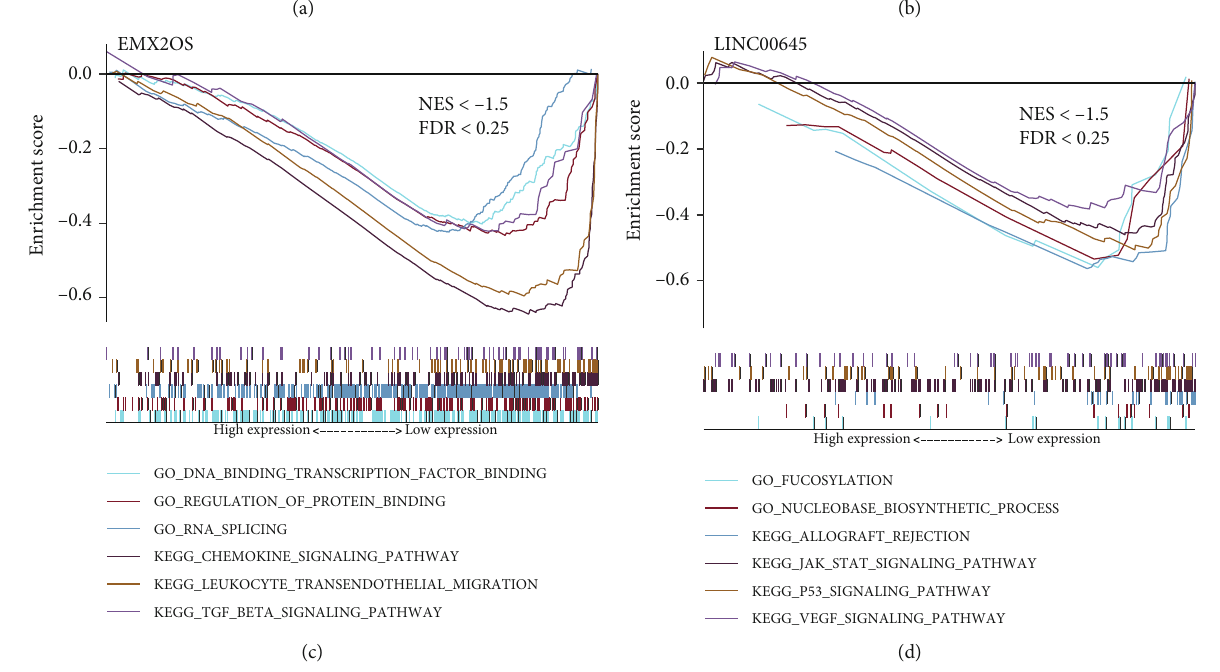
Figure 8: GSEA of the 4 lncRNAs. (a) ATP1A1-AS1. (b) CTD-3080P12.3. (c) EMX2OS. (d) LINC00645. GSEA: gene set enrichment